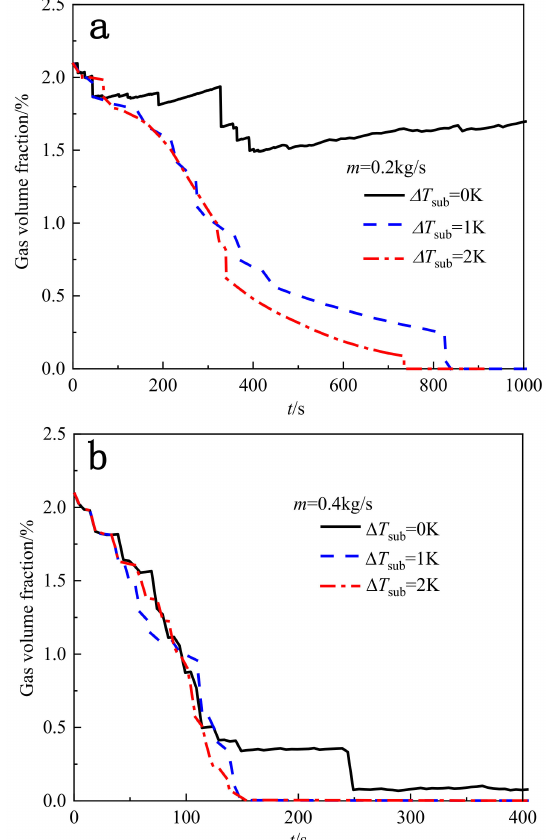
Figure 11. Influence of liquid subcooling on gas volume fraction variation in circulation flow process. ( a ) Cases under m = 0.2 kg/s; ( b ) Cases under m = 0.4